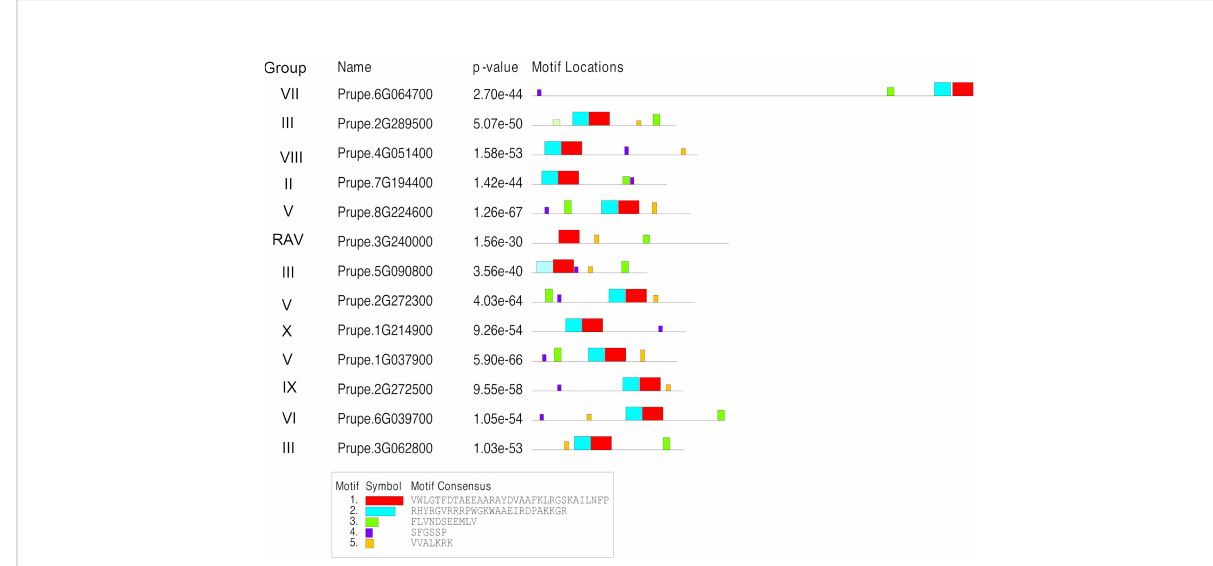
FIGURE 7 Gene structure and conserved motifs within thirteen peach ERF proteins identi fi ed through WGCNA as correlating in expression with downstream genes containing ERF binding motifs in their promoter sequences. Motifs identi fi ed using the MEME